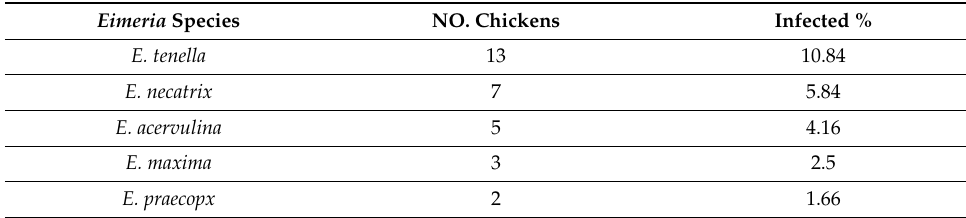
Figure 1. The infection rate of Eimeria parasites in domestic chickens. Table 2. The percentages of different types of Eimeria species in this